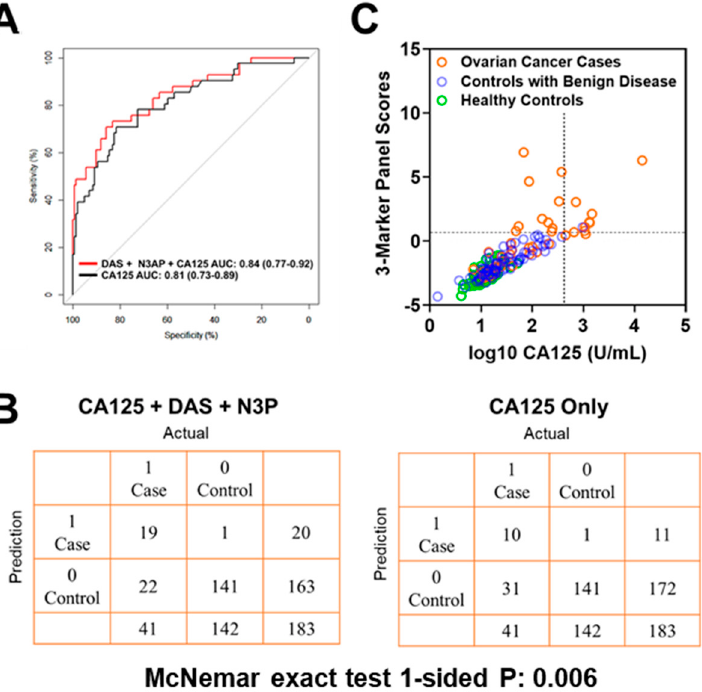
Figure 2. Classification performance of the 3-marker panel and CA125 in the Test Set. ( A ) Area under the curve for the 3-marker panel consisting of DAS + N3AP + CA125, and CA125 only. ( B ) Confusion matrix describing the performance of the classification model corresponding to the 3-marker panel and CA125 alone at 99% specificity. Statistical significance was determined by 1-sided McNemar exact test. ( C ) Scatter plot illustrating the distribution of the 3-marker panel scores (Y-axis) and log10 CA125 values (X ‐ axis). Broken lines represent 99% specificity cutoffs.